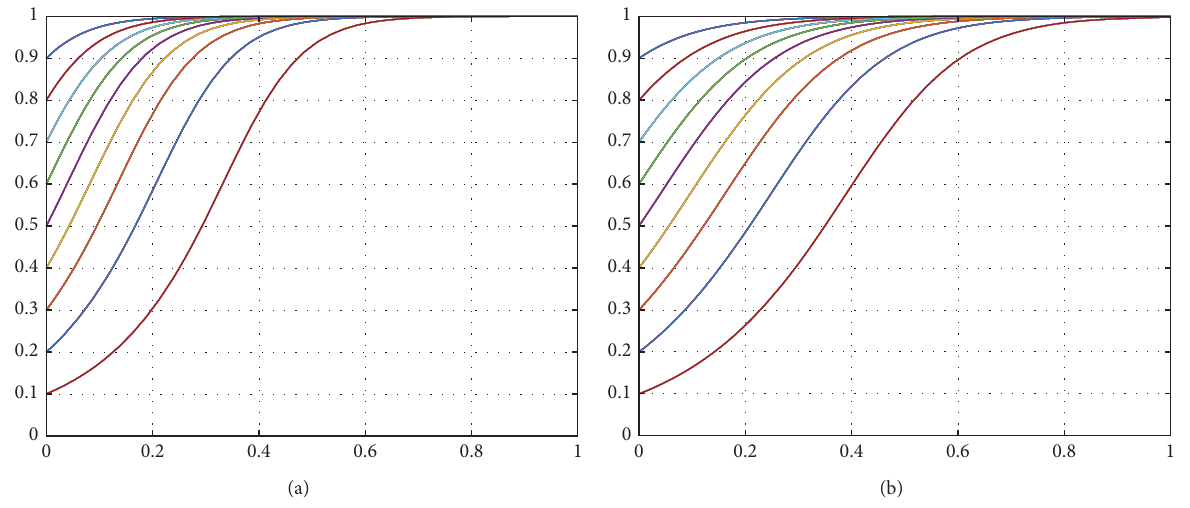
− β � 0 . 1; (b) β − β � 0 . 1 2 1 2